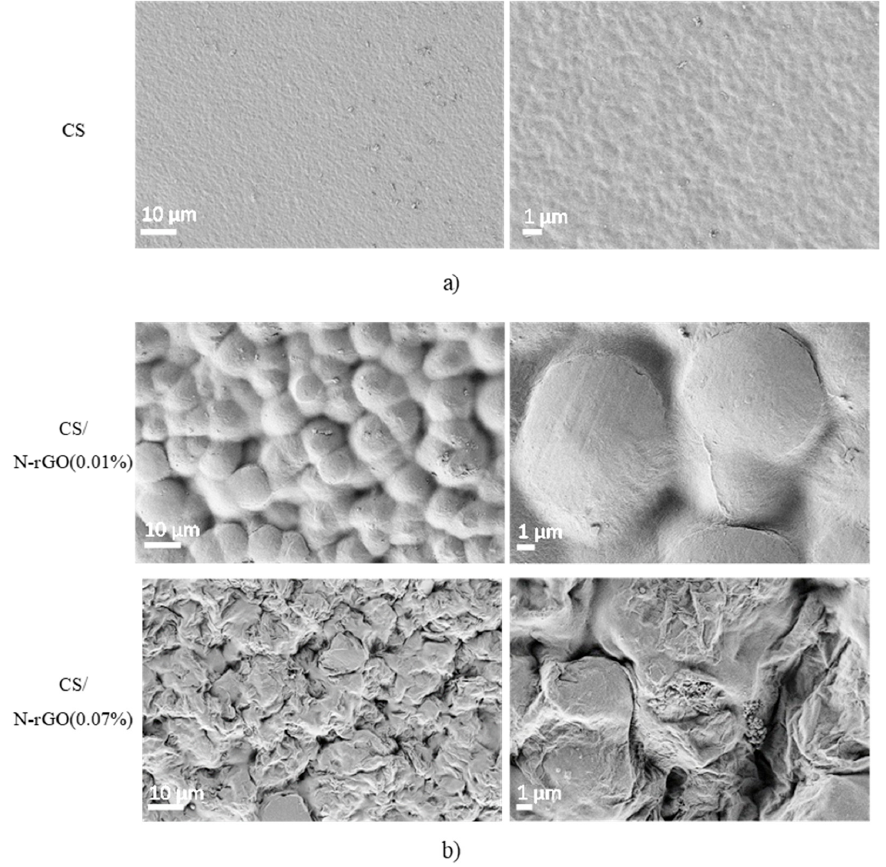
Figure 4. ζ potential of N ‐ rGO, N ‐ rGONRs, and N ‐ pEAO in the pH range 2–12.